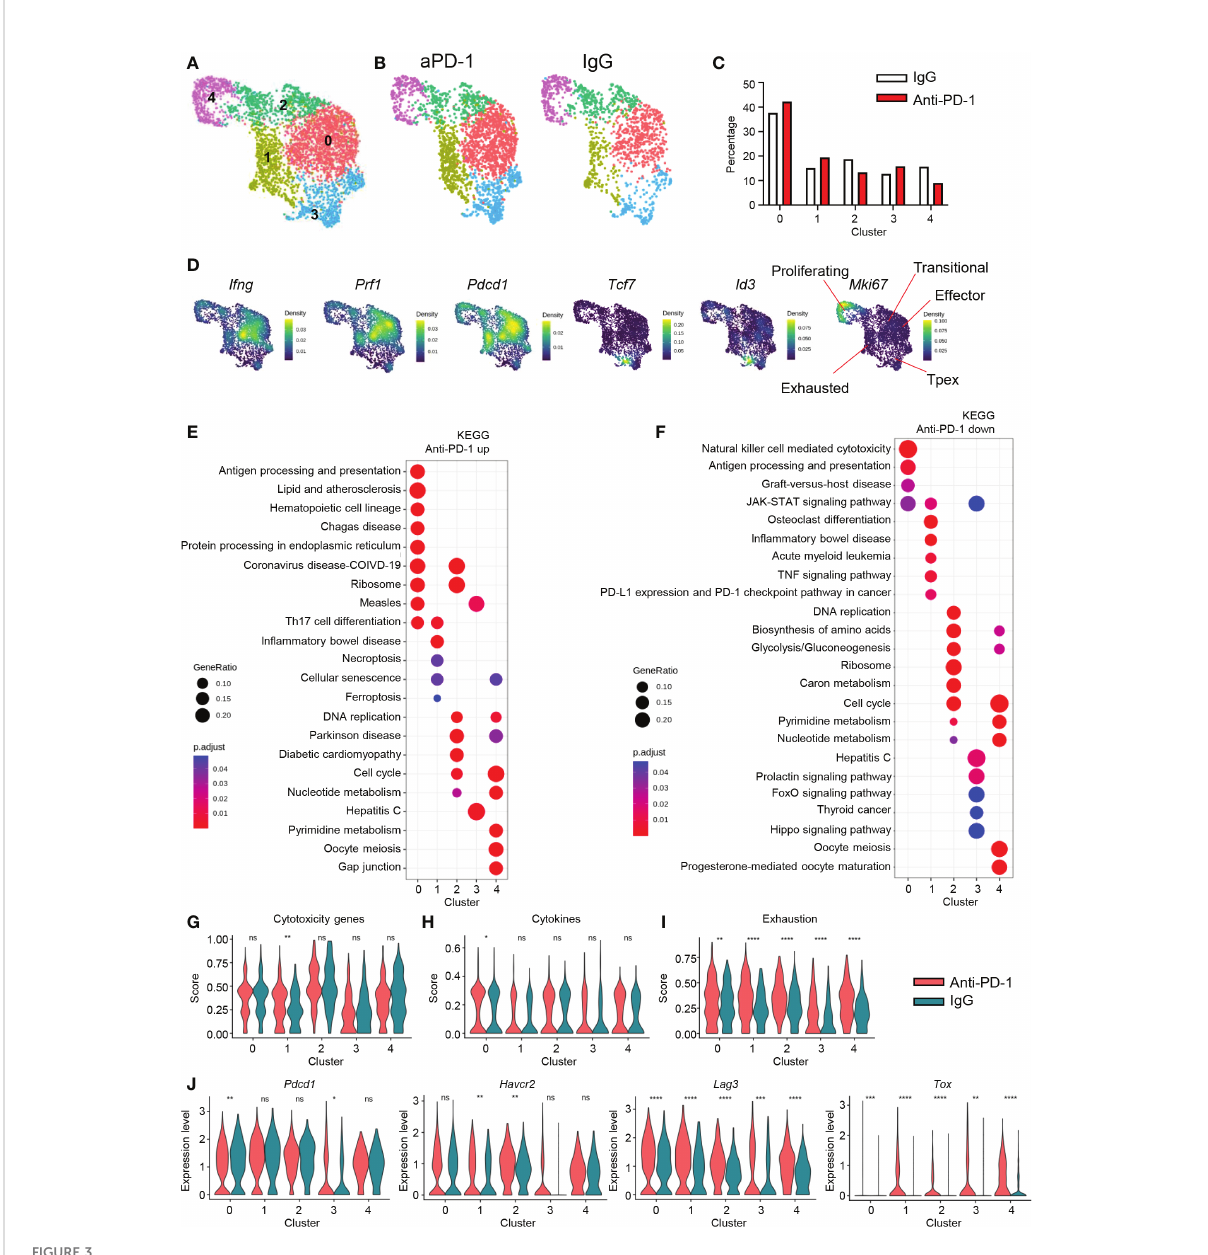
FIGURE 3 CD8 T-cell signatures after aPD-1 treatment. (A) CD8 T cells ( Cd3e + Cd8a + Cd4 − doublet − ) were re-clustered. CD8 T cells are shown by UMAP. (B, C) Differences in clusters between IgG and aPD-1 groups are shown by DimPlot (B) and bar graph (C) . (D) Expression densities of Ifng, Prf1, Pdcd1, Tcf7, Id3 , and Mki67 are shown with characteristics of clusters. (E, F) Pathways that were upregulated (E) and downregulated (F) by aPD- 1 treatment were analyzed using the KEGG database. (G – I) Gene scores of clusters were calculated for cytotoxicity genes ( Gzma, Gzmb, Gzmc, Prf1 ) (G) , cytokine genes ( Ifng, Il2, Tnf ) (H) , and exhaustion genes ( Pdcd1, Havcr2, Lag3, Tox, Tigit, Cd160 ) (I) . (J) Expression of Pdcd1, Havcr2, Lag3 , and Tox was analyzed for clusters. Data in (G – J) were analyzed by the stat_compare_means function with unpaired t-test. * P <0.05, ** P <0.01, *** P <0.001, **** P <0.0001. ns, not signi fi